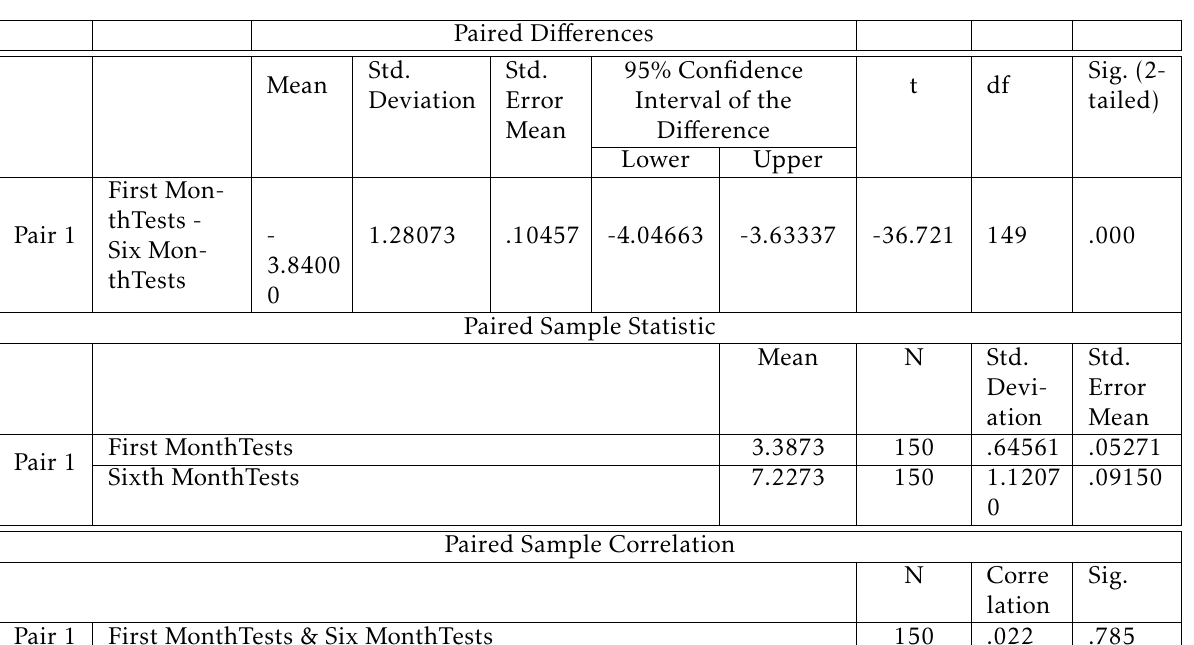
Table 2. Paired Samples Test of English vocabulary meaning MCQ’s for first and sixth